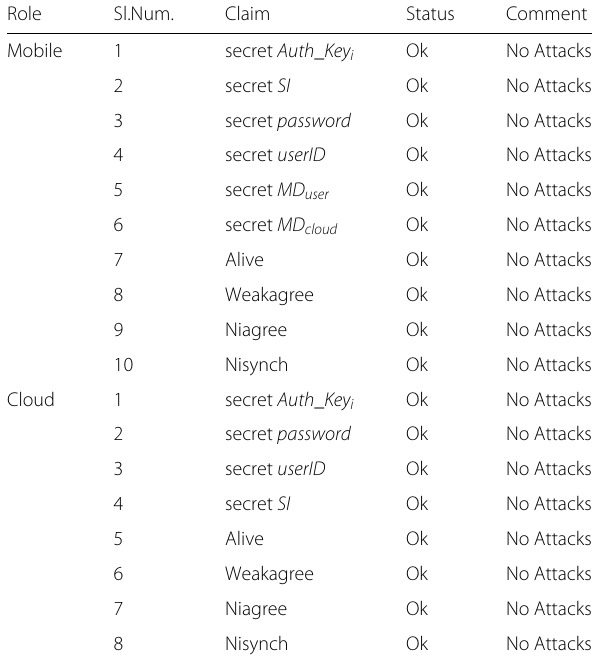
Table 1 Security analysis of the proposed scheme using Scyther during authentication phase Role